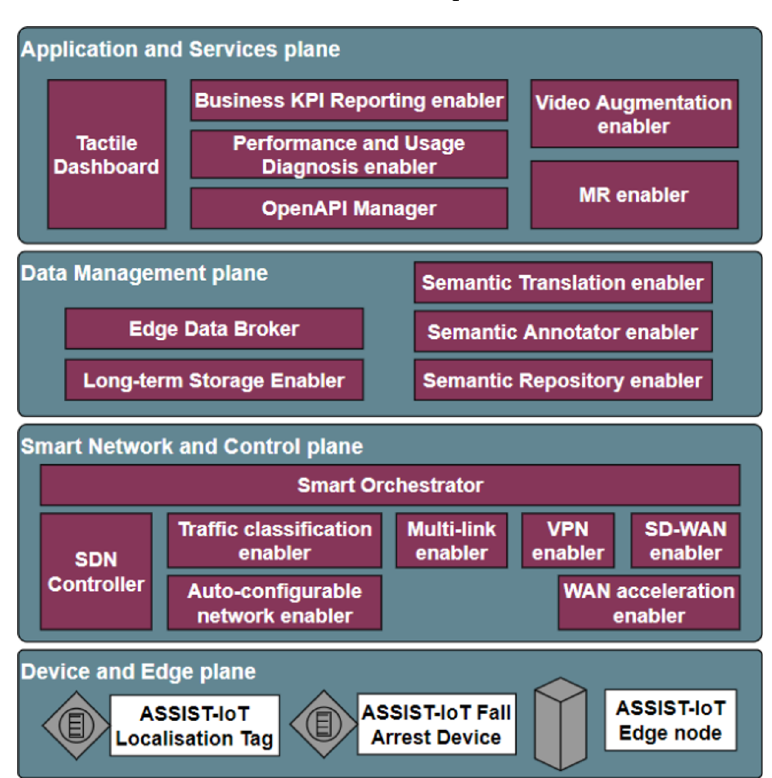
Figure 2. ASSIST-IoT functional view—planes.